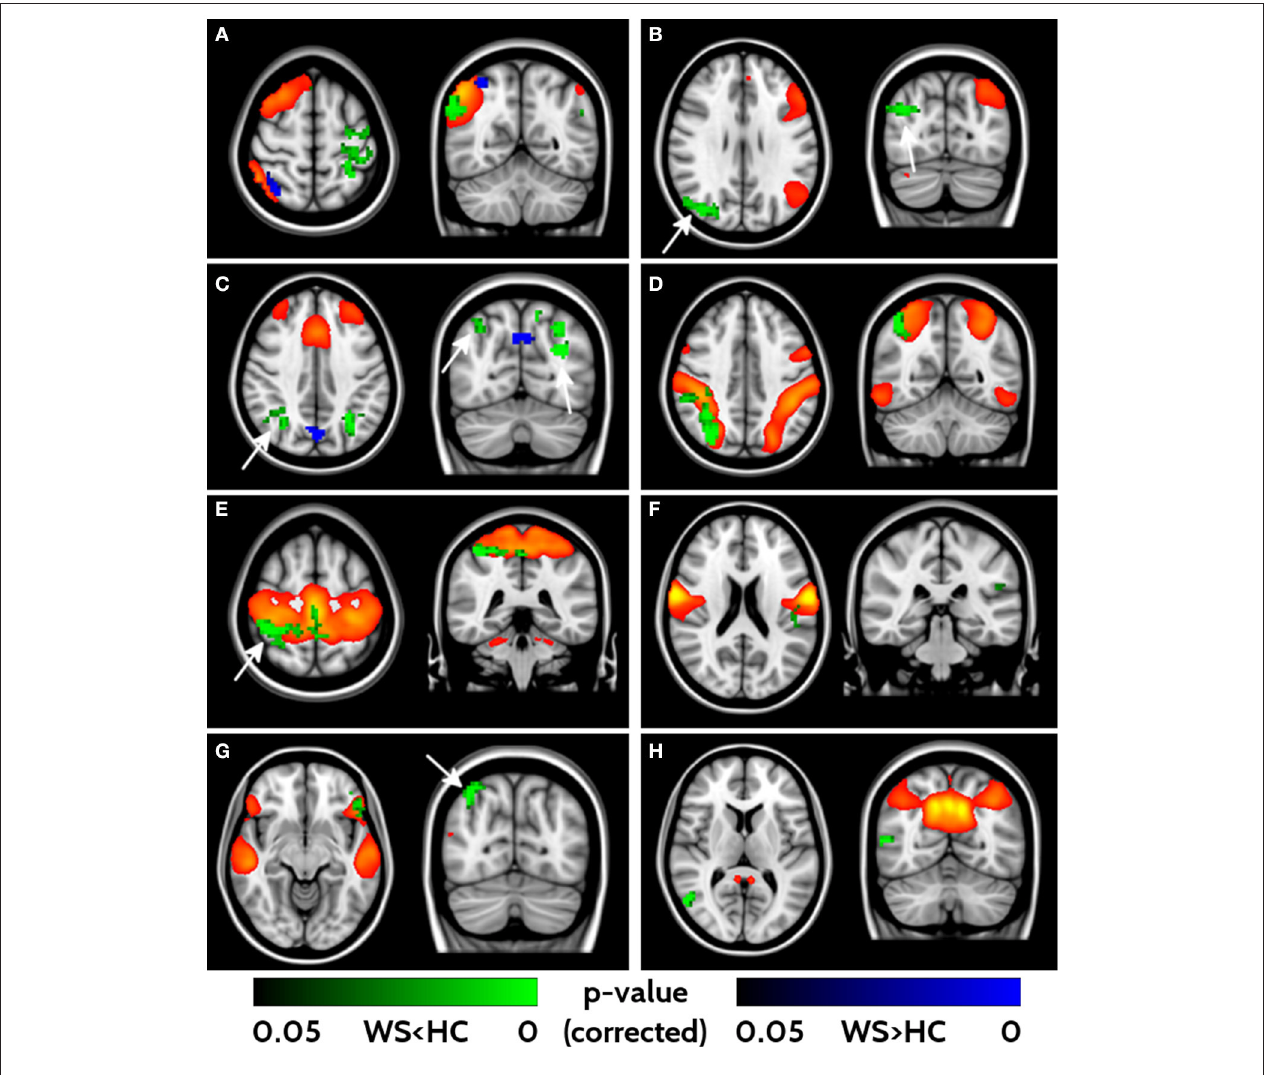
FIGURE 3 | Impaired functional connectivity in WS patients. Right- and left-frontoparietal networks (A, B) , executive control network (C) , dorsal attention network (D), sensorimotor networks (E, F) , ventral stream (G) and default mode networks (H) showed significant differences in functional connectivity between WS and HCs. Yellow/red voxels represent the areas involved in each network. Areas of lower functional connectivity (FC) in WS patients compared to HCs are shown in green, whereas areas of higher FC in WS patients compared to HCs are shown in blue. Arrows point at bilateral parieto-occipital clusters characterized by impaired FC. Significance level is set at p < 0.05 corrected for multiple